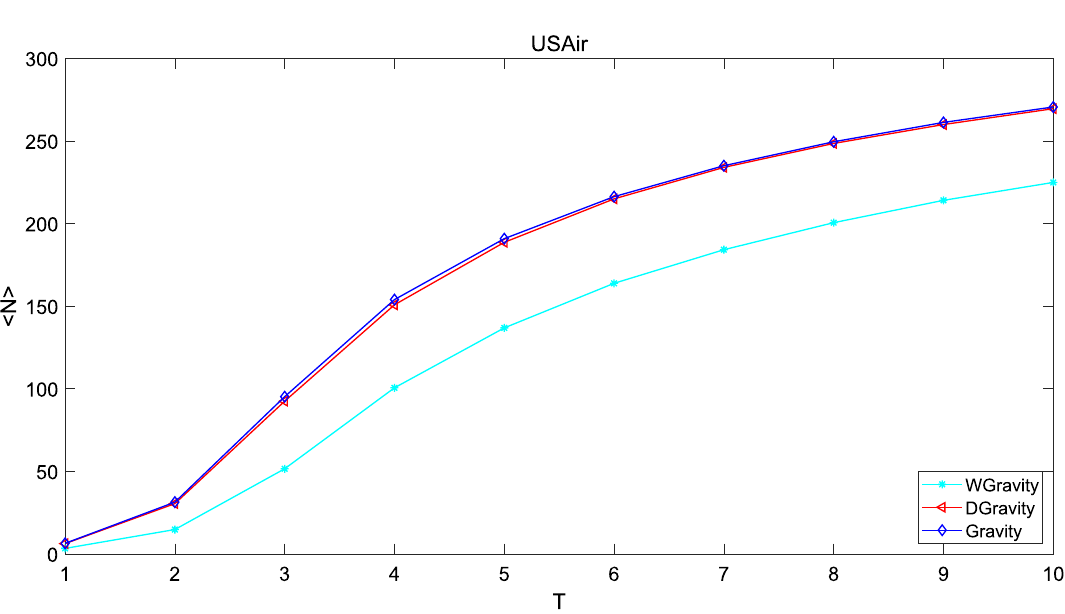
Figure 14. This figure compares the new model with Gravity model and weighted gravity model based on average infected nodes in network USAir. The new model performs slightly worse than Gravity model, but much better than weighted gravity model.